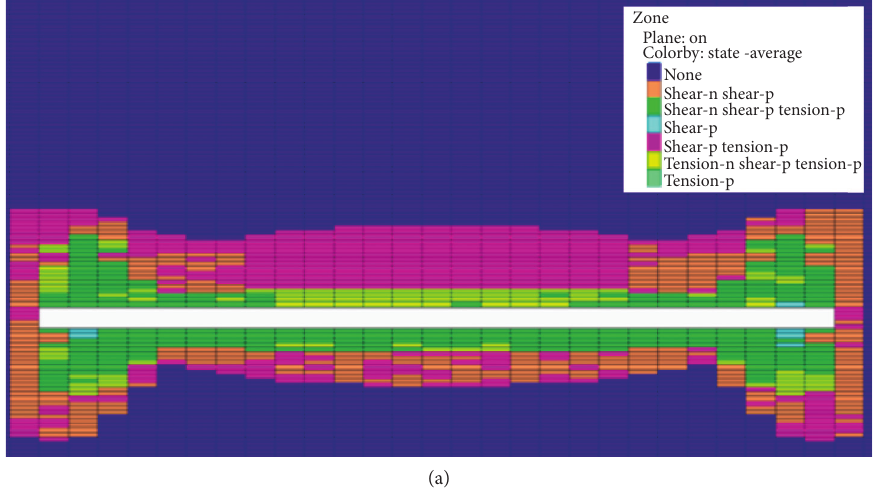
Zone Plane: on Colorby: state